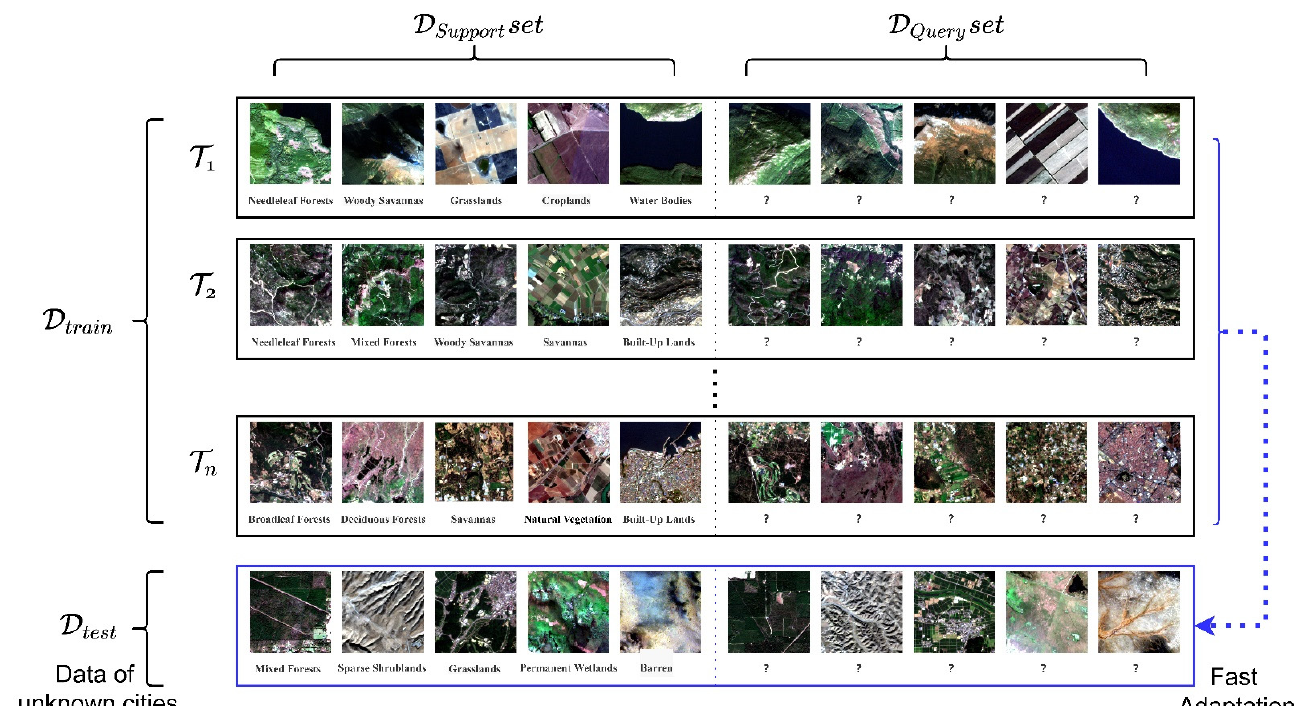
Figure 1. The schematic diagram of the data division from a 5-way 1-shot few-shot remote sensing scene classification. In (cid:2270) (cid:3047)(cid:3045)(cid:3028)(cid:3036)(cid:3041) , each task (cid:2286) represents a dataset extracted from a certain city. We use the (cid:2270) (cid:3020)(cid:3048)(cid:3043)(cid:3043)(cid:3042)(cid:3045)(cid:3047) set to learn the internal optimization weights, and the (cid:2270) (cid:3018)(cid:3048)(cid:3032)(cid:3045)(cid:3052) set to update the weights. Further, we use the self-supervised embedding optimization module to balance the requirements for feature classification tasks between multiple images collected at different times and places and use the (cid:2270) (cid:3047)(cid:3032)(cid:3046)(cid:3047) to test the generalization performance of the model to unknown cities.